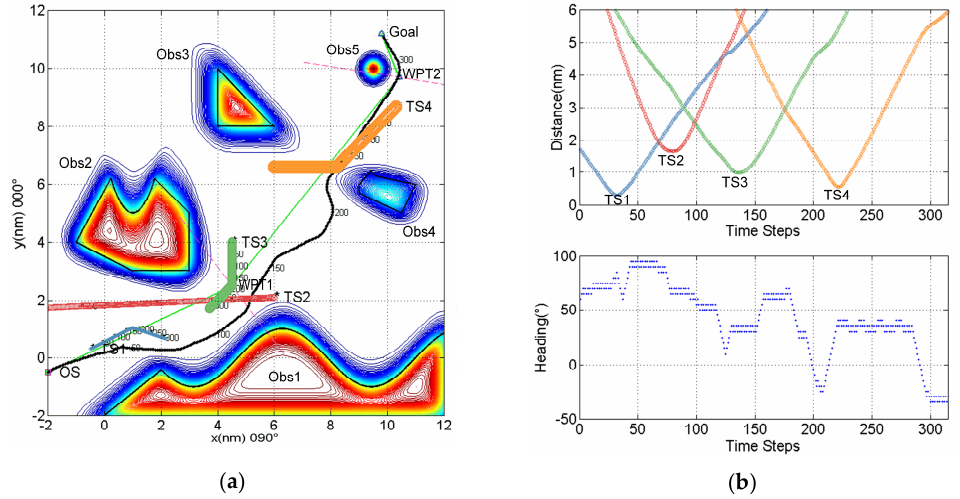
Figure 17. ( a ) After clearing Obs4 and TS4, the own ship heads for WPT2 and then reaches WPT2 and the final goal. Although the goal is very close to Obs5, the own ship can still reach the goal and keep a safe passing distance of 0.57 nm from the point obstacle Obs5. ( b ) The above figure shows the distance between the own ship and each TS at every time step. The below figure shows the heading changes of the own ship at each time step, where –50° means 310° in circular notation. Although the heading angle of the own ship has some small fluctuations, the trajectory direction reflects substantial alterations of course when avoiding TSs, which is in line with Rule 16 of COLREGS.